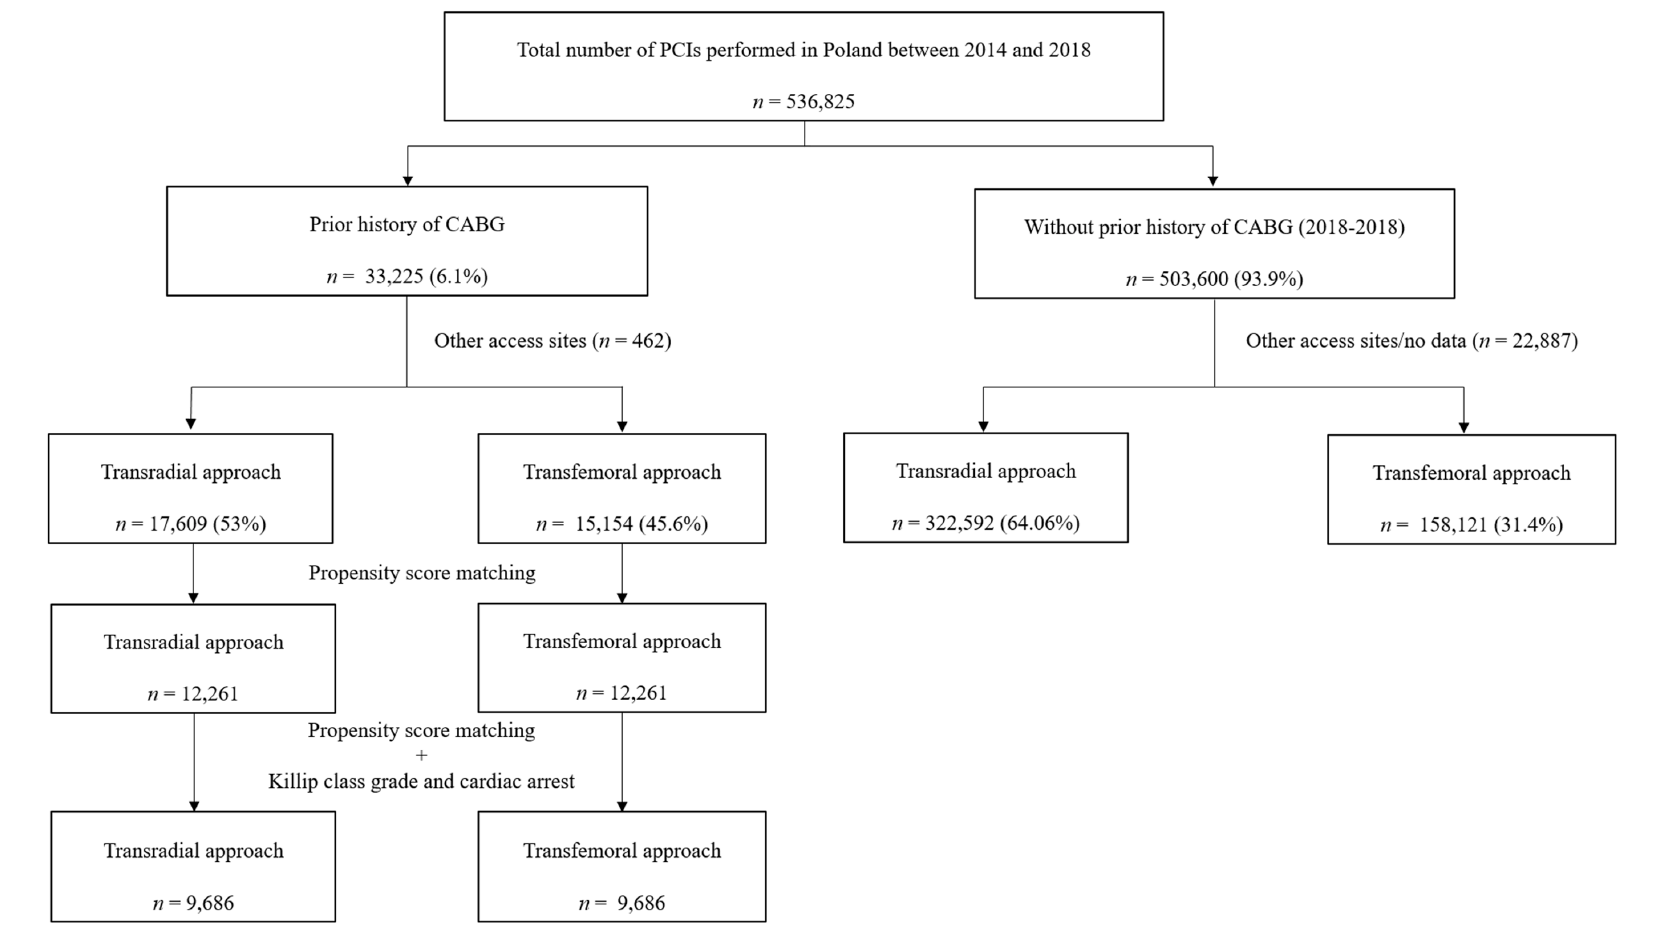
Figure 1. Flow of patients through the following stage of analysis. CABG = coronary artery bypass grafting; PCI = percutaneous coronary intervention.